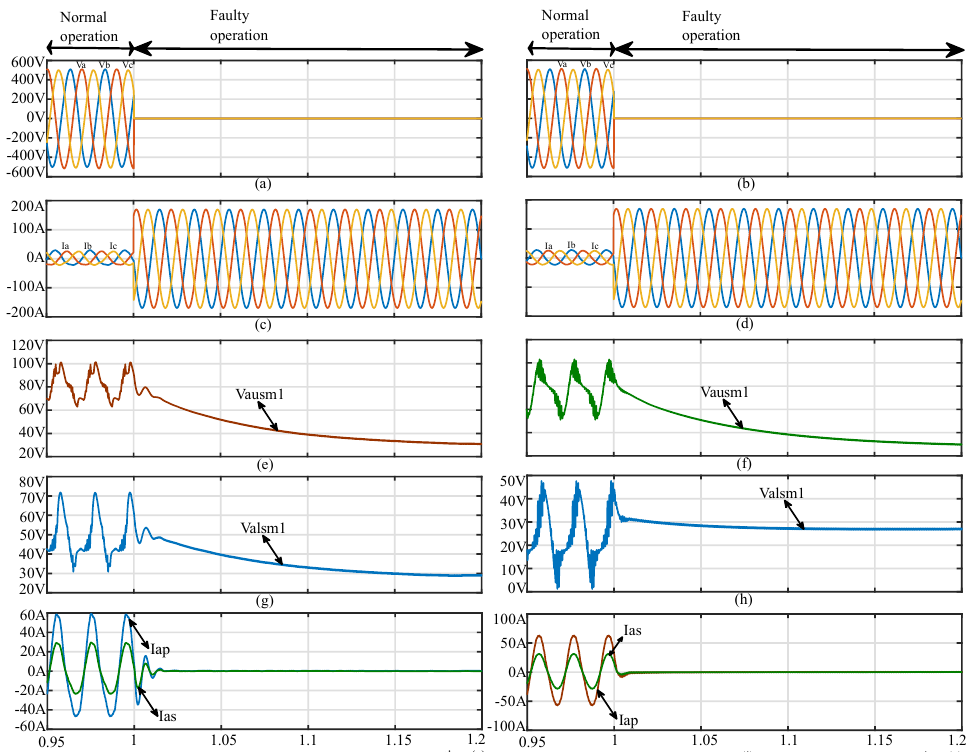
Figure 14. Converter during short circuited condition. ( a ) Line voltages of converter with d-q control and SPWMLSC, ( b ) line voltages of converter with d-q control and SPWMPSC, ( c ) line currents of converter with d-q control and SPWMLSC, ( d ) line currents of converter with d-q control and SPWMPSC, ( e ) SPWMLSC implemented upper arm phase-a SM-1 capacitor voltage, ( f ) SPWMPSC implemented upper arm phase-a SM-1 capacitor voltage, ( g ) SPWMLSC implemented lower